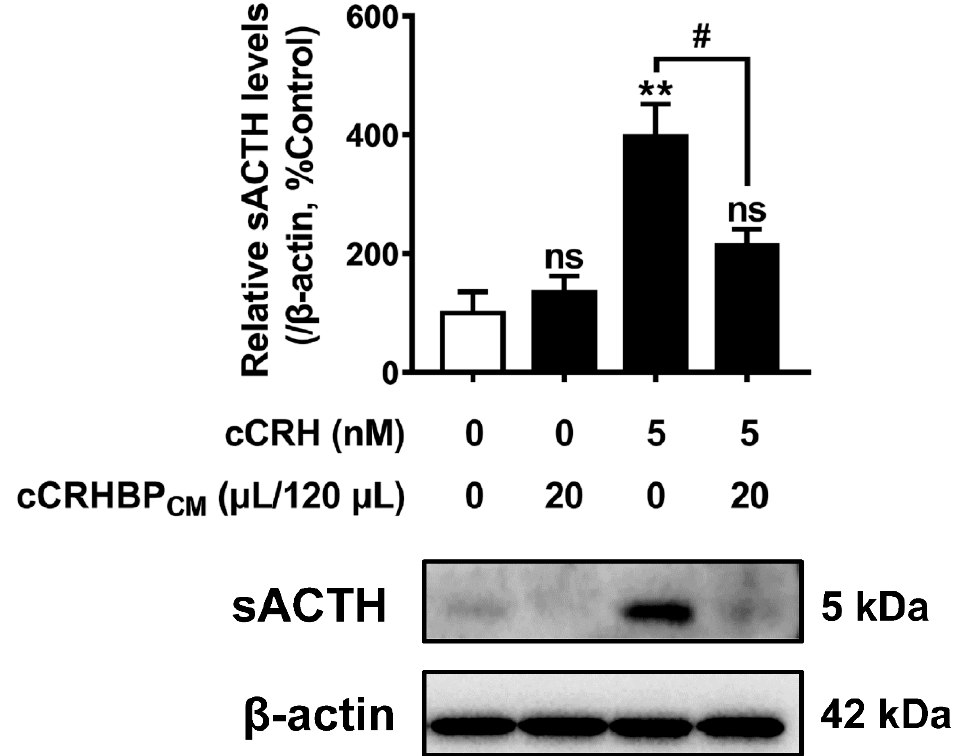
Figure 6. Effect of cCRHBP conditional medium (cCRHBP CM ) on the ACTH secretion from cultured chick pituitary cells. The sACTH band at ∼ 5 kDa (secretory ACTH level detected in culture medium) was semiquantified by densitometric analysis. Their relative levels were normalized by that of β -actin in pituitary cell lysate and then expressed as a percentage of the control group. Each data point represents the mean ± SEM of 3 replicates ( n = 3). **, p < 0.01, vs. control group (in the absence of cCRH and cCRHBP CM ); ns, no statistical difference vs. control group; #, p < 0.05, vs. cCRH treatment group (in the absence of cCRHBP CM ). Representative set of Western blots is shown at the bottom of each graph.